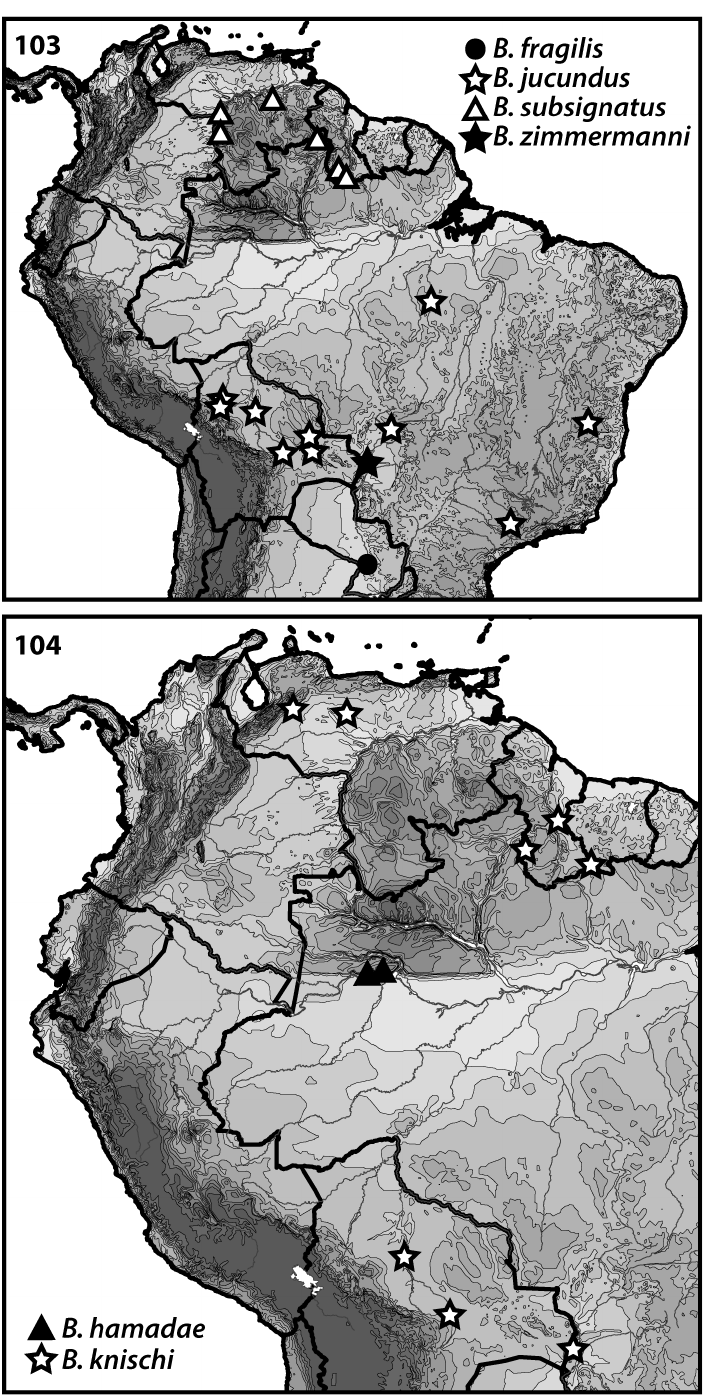
Figures 103–104. Distributions of Bidessodes species based on examined specimens and published